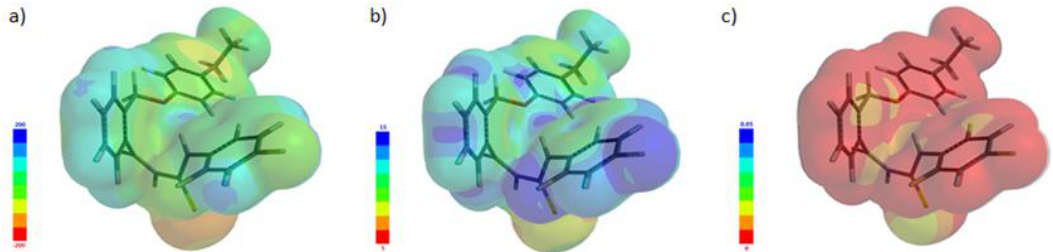
Figure 5. ( a ) The optimized geometry and electrostatic potential pattern of the surface of compound 5d (red, negative, high electron density; blue, positive area, low electron density). ( b ) The optimized geometry and local ionization potential map of compound 5d . ( c ) The optimized geometry and LUMO map of compound 5d .